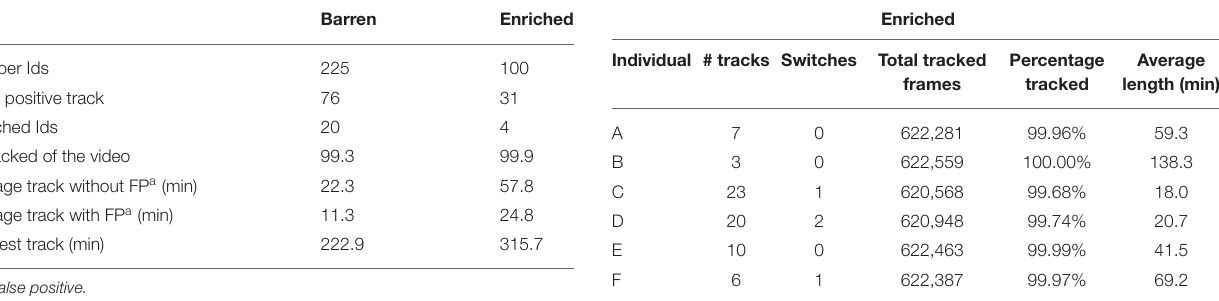
TABLE 3 | Tracking summary per individual in enriched